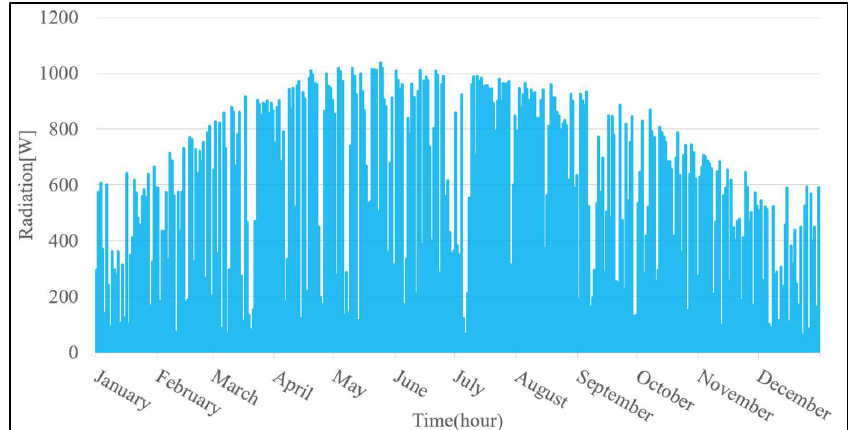
Figure 11. Hourly solar irradiation in Fukuoka (Source: JMA).